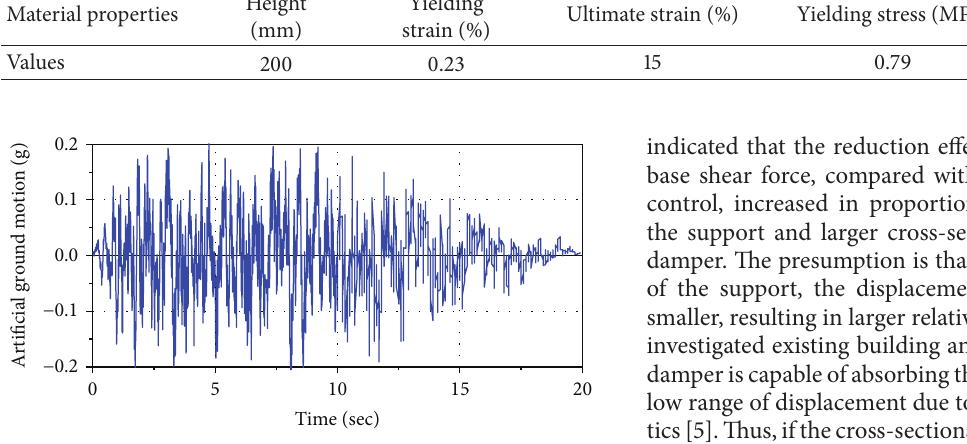
Figure 4: Artificial ground motions used in the boundary nonlinear